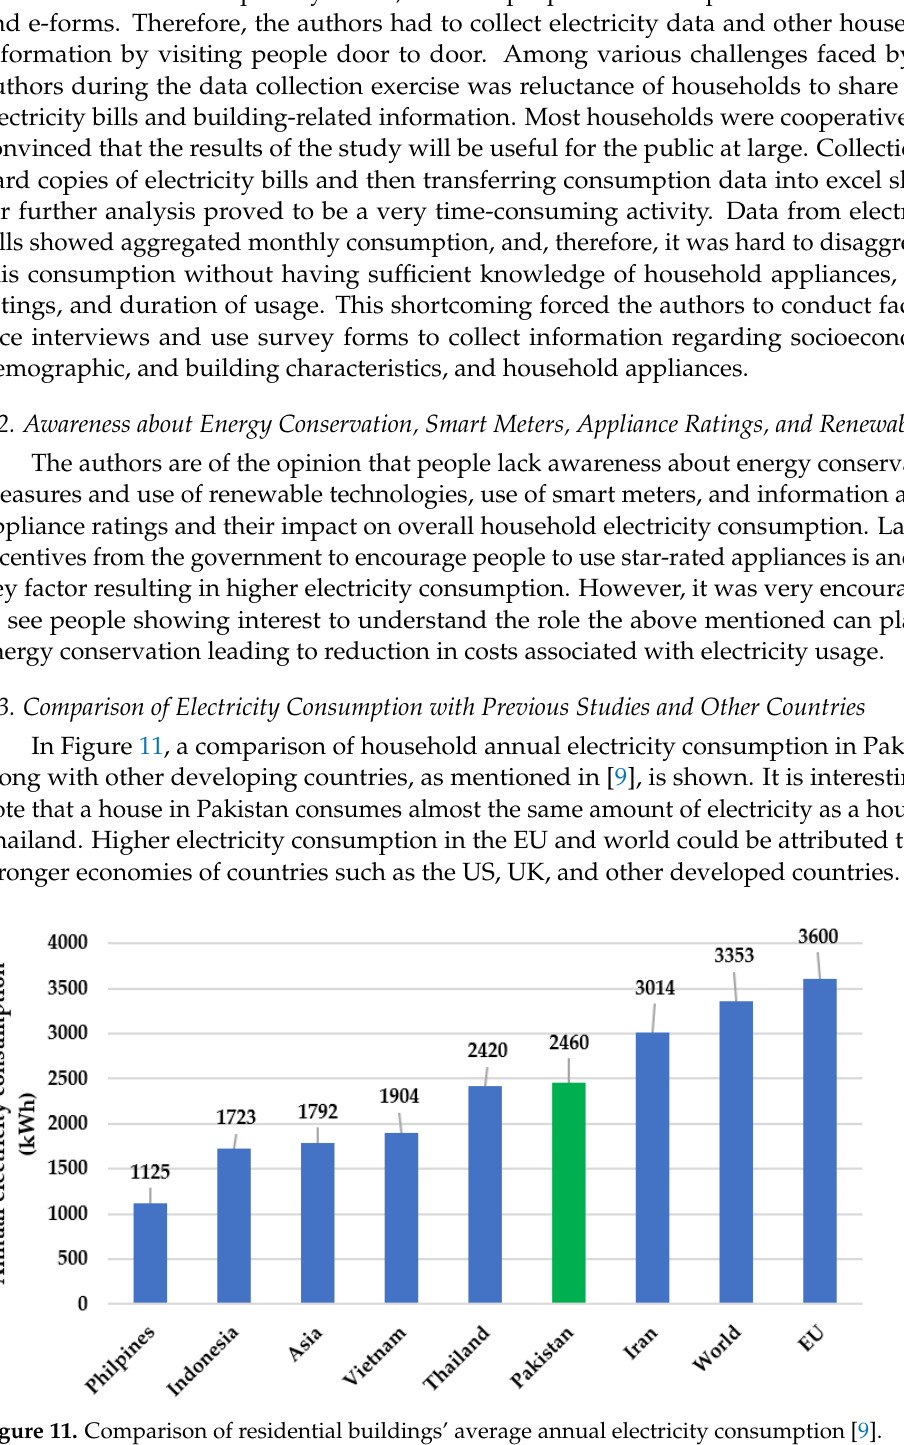
Figure 11. Comparison of residential buildings’ average annual electricity consumption